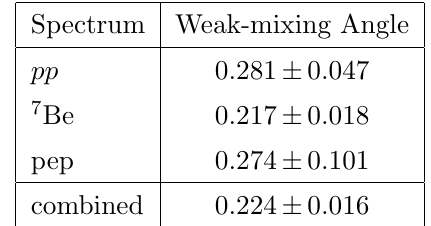
Figure 1 . The SM sin 2 ( (cid:18) W ) (cid:12)t using the solar low-energy spectrum of pp, 7 Be, pep reaction measured by Borexino experiment. From bottom to top, the 1 (cid:27) and 90%C.L. bands are shown. The marked asymmetry in the bound from pep data is explained in the text.